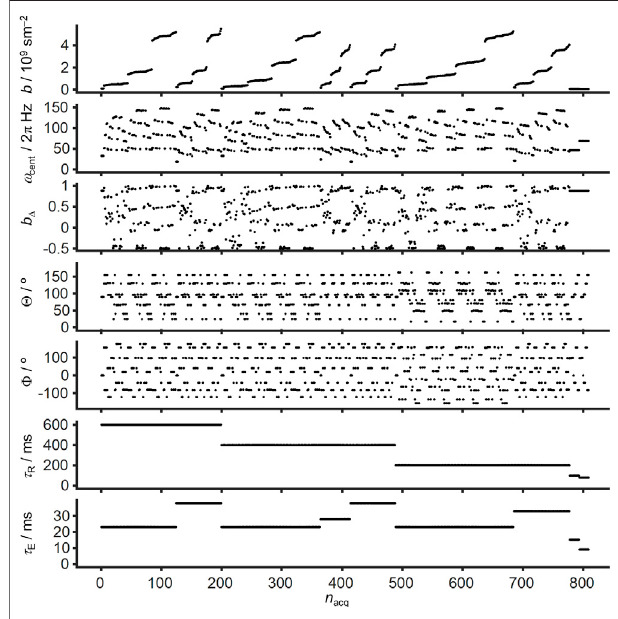
FIGURE 1 | Example acquisition scheme for massively multidimensional diffusion-relaxation correlation MRI. Free gradient waveforms combining elements of conventional DTI with oscillating gradient and tensor-valued encoding are used to explore the effectively 5D acquisition space spanned by the trace b , orientation ( Θ , Φ ), centroid frequency ω cent , and normalized anisotropy b Δ of the tensor-valued encoding spectrum b ( ω ). Variation of the repetition time τ R and echo time τ E gives access to two additionaldimensions,resultingina7Dacquisition.Theacquisitionpointindex n acq is sorted according to decreasing τ R , increasing τ E , and increasing b